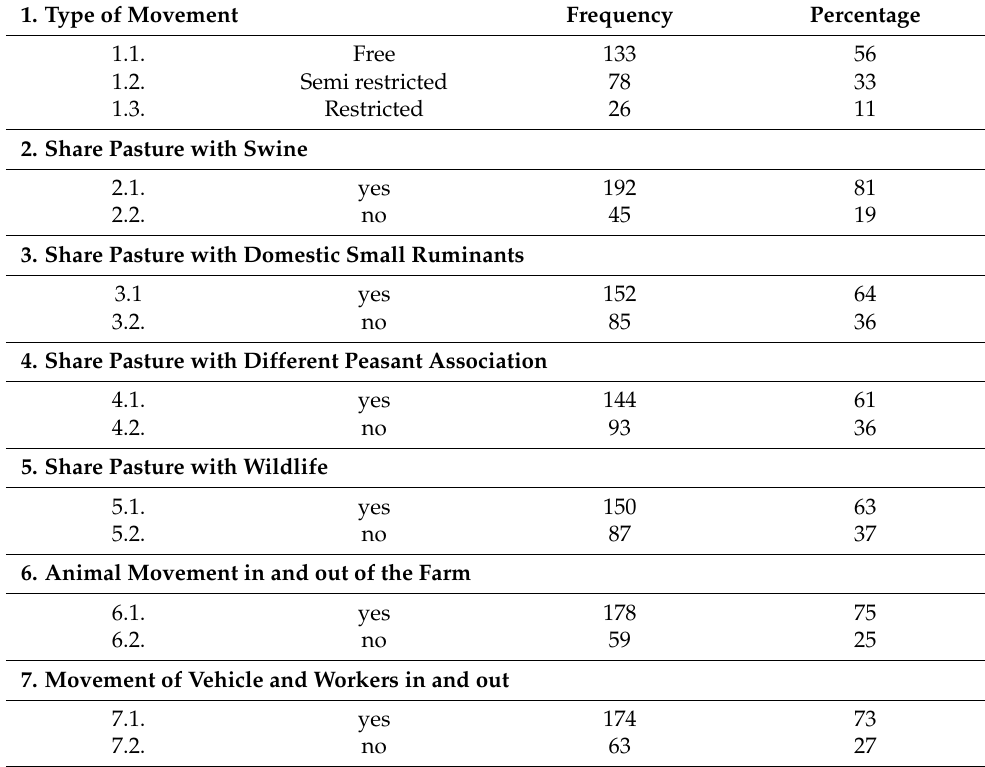
Table 1. Frequency of respondents with different risk factors to FMD occurrence (2018 to 2020) ( N =